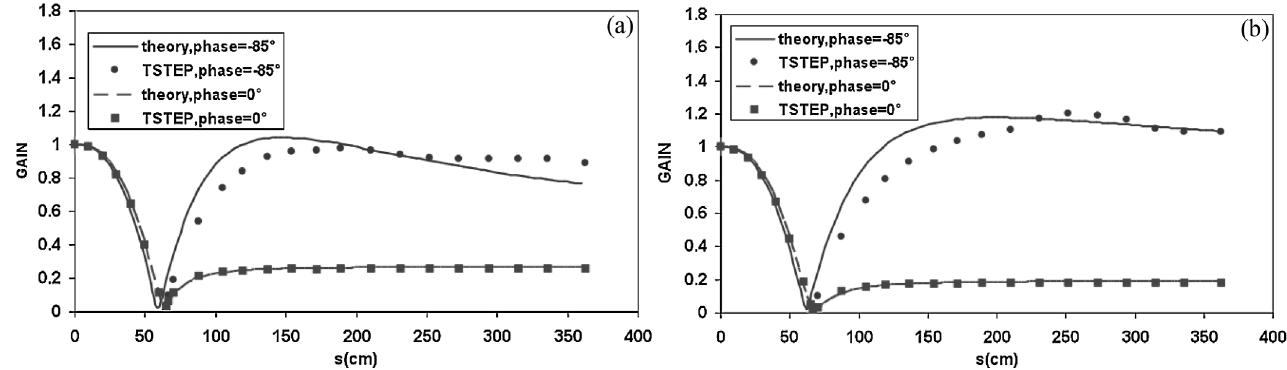
phase.FIG. 11. Comparison between TSTEP simulations and linear theory for the linear gain through the bunch compressor over a spectrum of perturbation wavelengths; (a) is for a beam accelerated ‘‘on crest’’ (uncompressed), C ¼ 1 , (cid:2) ¼ (cid:1) 82 deg factor C ¼ 2 , (cid:2) 0